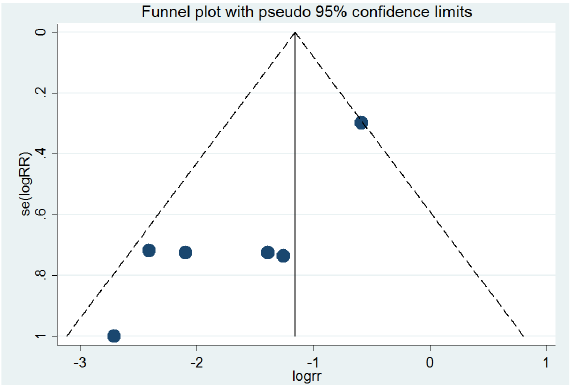
Figure 4: Forest plot of sensitivity analysis Figure 5: Begg’s funnel plot for evaluation publication